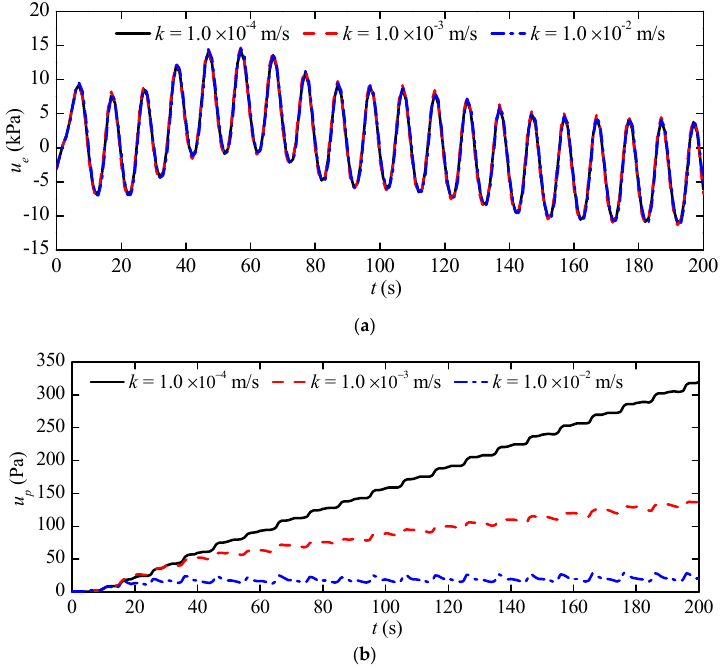
Figure 4 . Variations of ( a ) oscillatory pore pressure, 𝑢 (cid:3032) and ( b ) residual pore pressure, 𝑢 (cid:3043) at a specific point for different soil